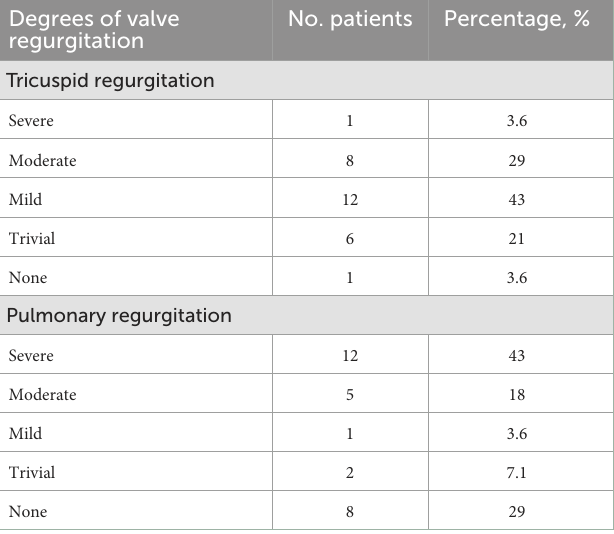
TABLE 3 Preoperative valve regurgitation on echocardiograms of patients.